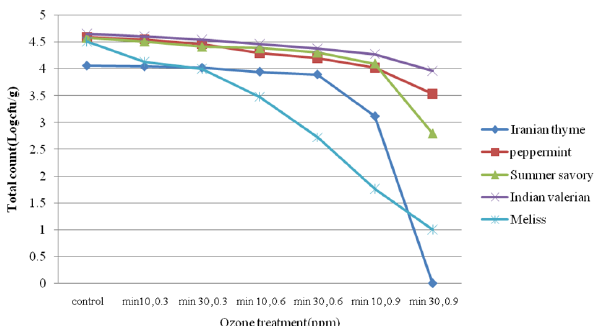
Fig. 3. The effect of treatment of Ozone gas on the total count in medicinal plants